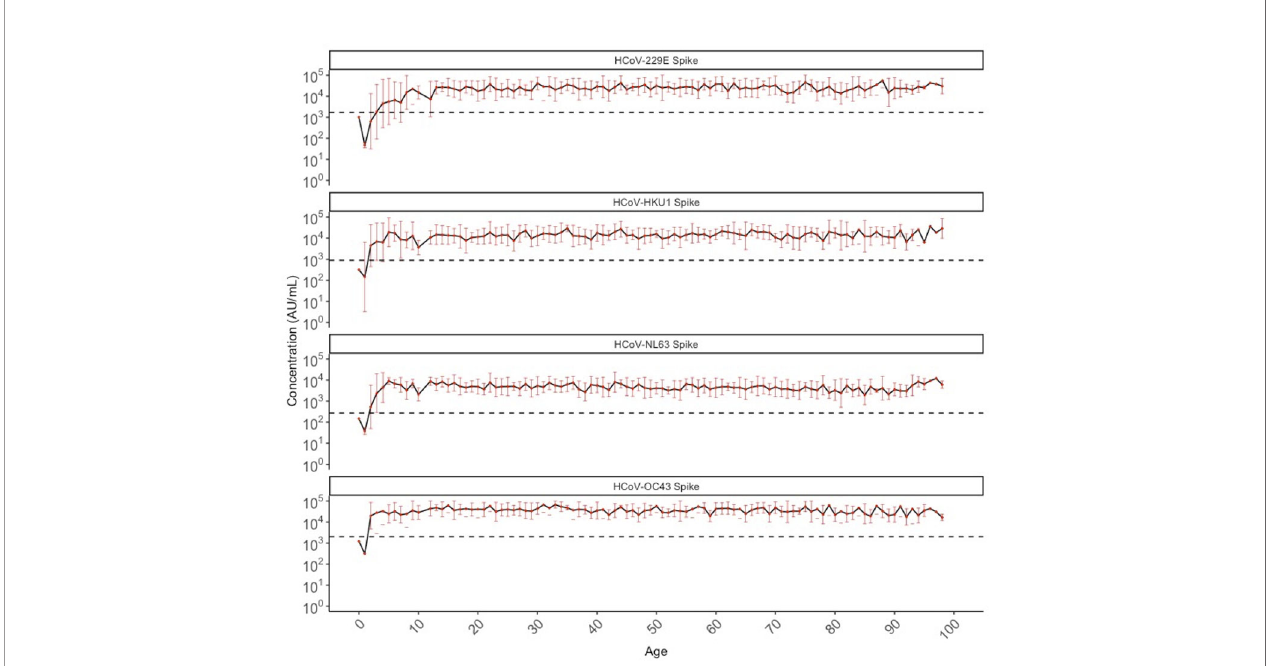
FIGURE 1 | Geometric mean IgG antibody titres against HCoV-229E, HCoV-HKU1, HCoV-NL63, and HCoV-OC43 spike in SARS-CoV-2 sero-negative populations (N = 887) by chronological age. SARS-CoV-2 sero-negative populations include all 2013 individuals (N = 407) and SARS-CoV-2 sero-negative individuals from 2020 (N = 480). Red dots indicate the geometric mean antibody titres for each HCoV among all individuals of that age (in years), with the black solid line connecting geometric means. Red bars represent upper and lower standard deviations. Black dashed lines describe the positivity cutoff for each antigen